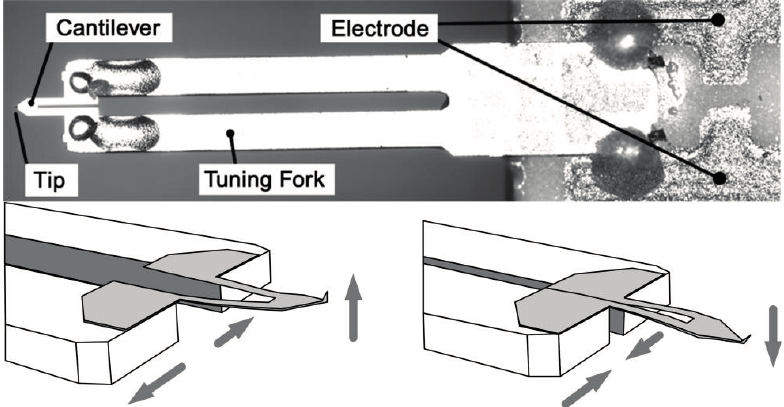
Figure 2. The appearance and motion of an Akiyama